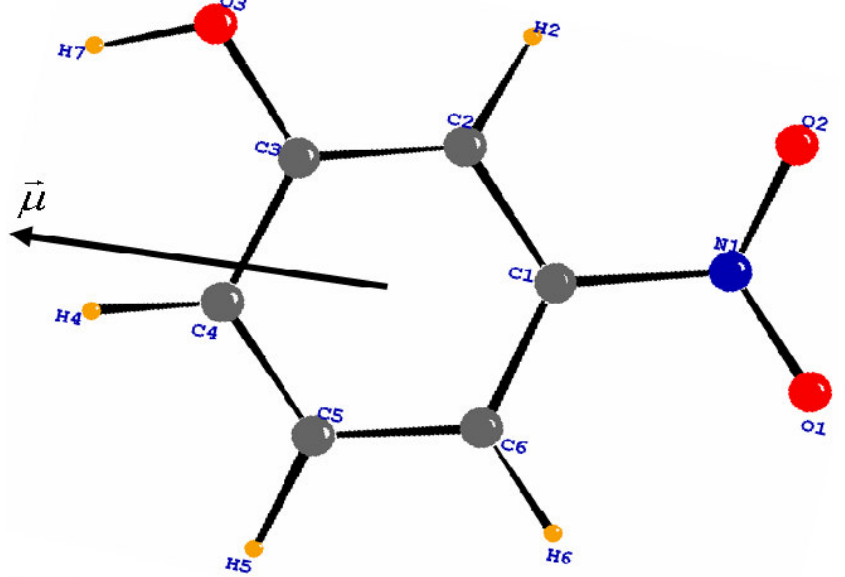
Figure 5. Residual density map: